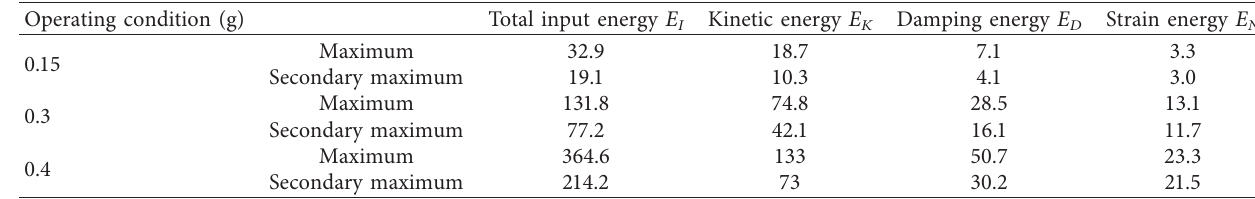
Figure 7: Accumulated elastic strain energy diagrams of tunnel structures with different Poisson’s ratios (unit: J). (a) 0.2; (b) 0.3; (c) 0.4. Table 3: The maximum and secondary maximum of each energy (unit: 10 10